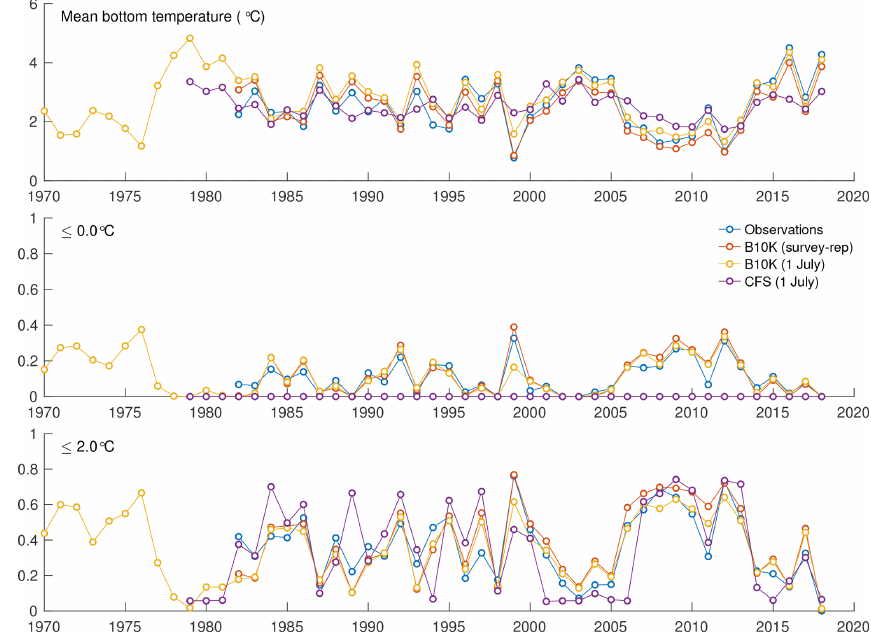
Figure 5. Annual indices of observed versus modeled bottom temperature, including average bottom temperature in the eastern shelf survey area, fraction of the survey area less than 0 ◦ C, and fraction of the survey area less than 2 ◦ C.